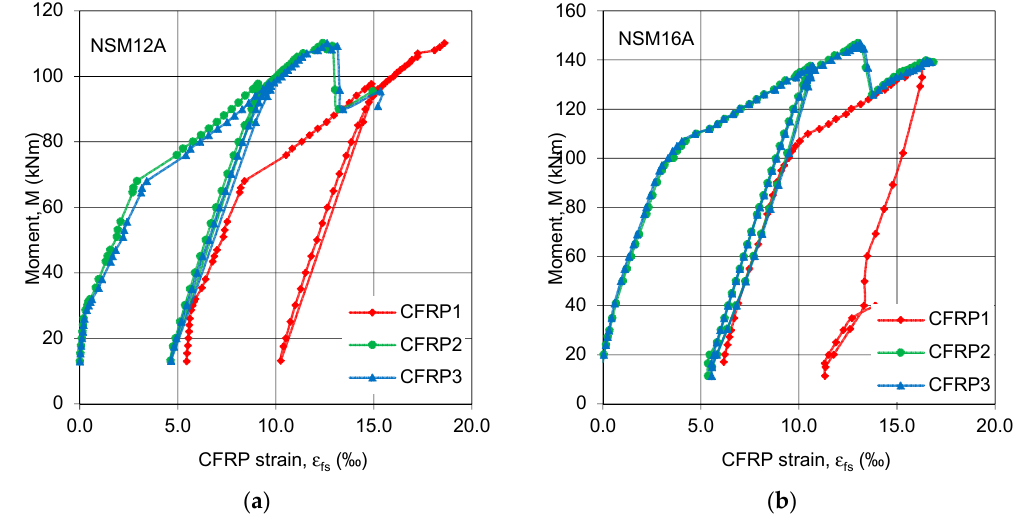
Figure 9. Bending moment vs. CFRP strain curves in beams of series A: ( a ) NSM12A; and ( b ) NSM16A.